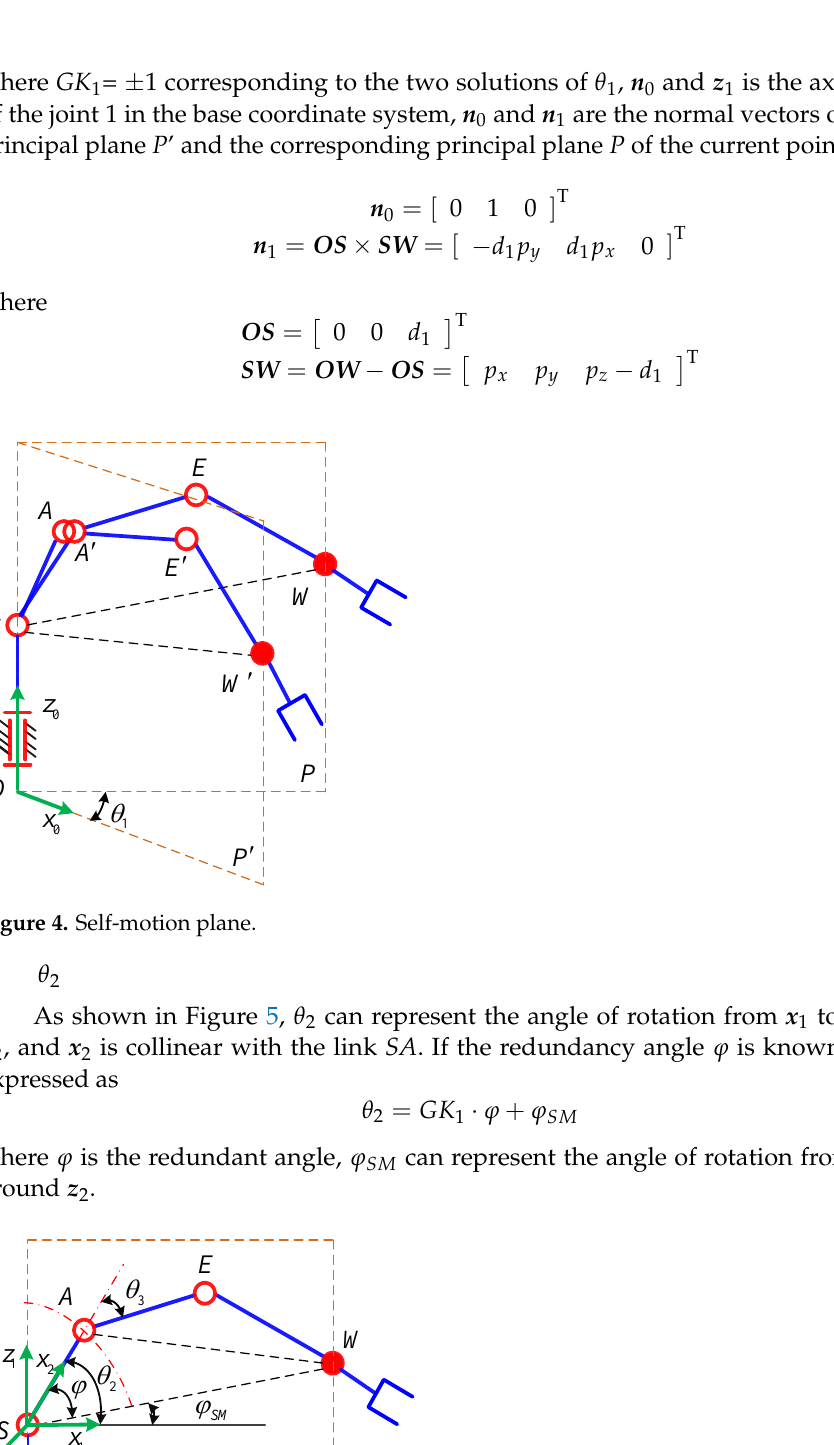
P  E  3   Figure 6. Position of the elbow E. 4.